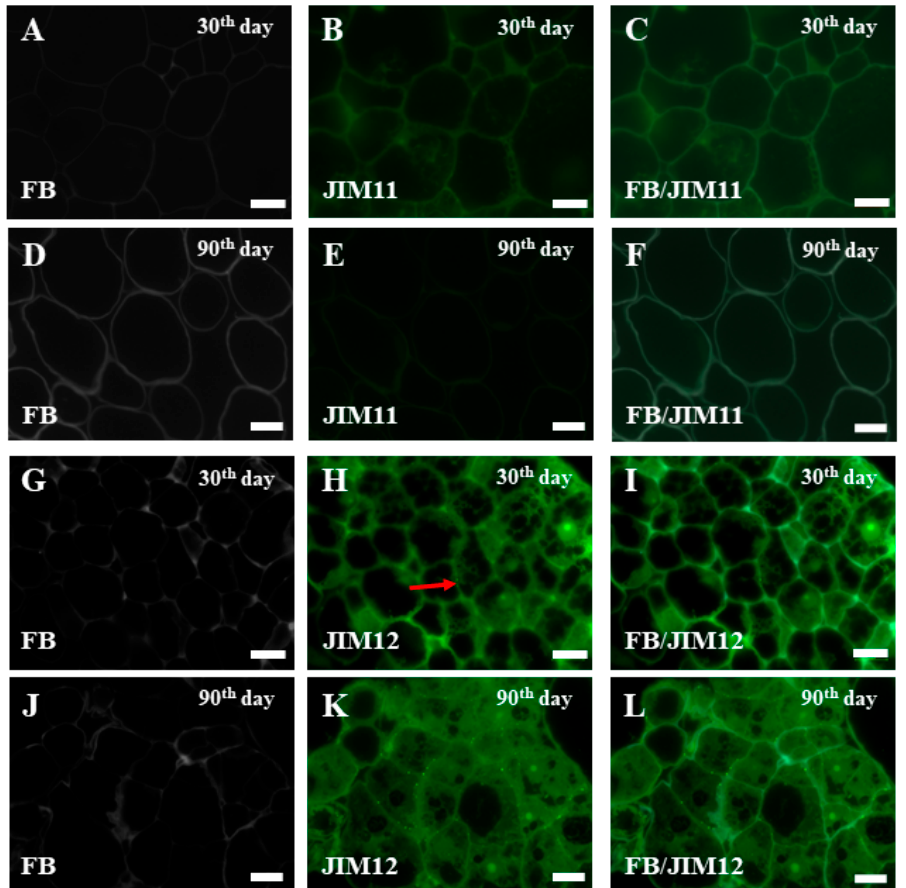
Figure A2. Immunolocalisation of LM2 ( A – F ) in B. distachyon callus. ( A – C ) 30th day of cultivation; ( D – F ) 90th day of cultivation. Scale bars, 10 μ m.